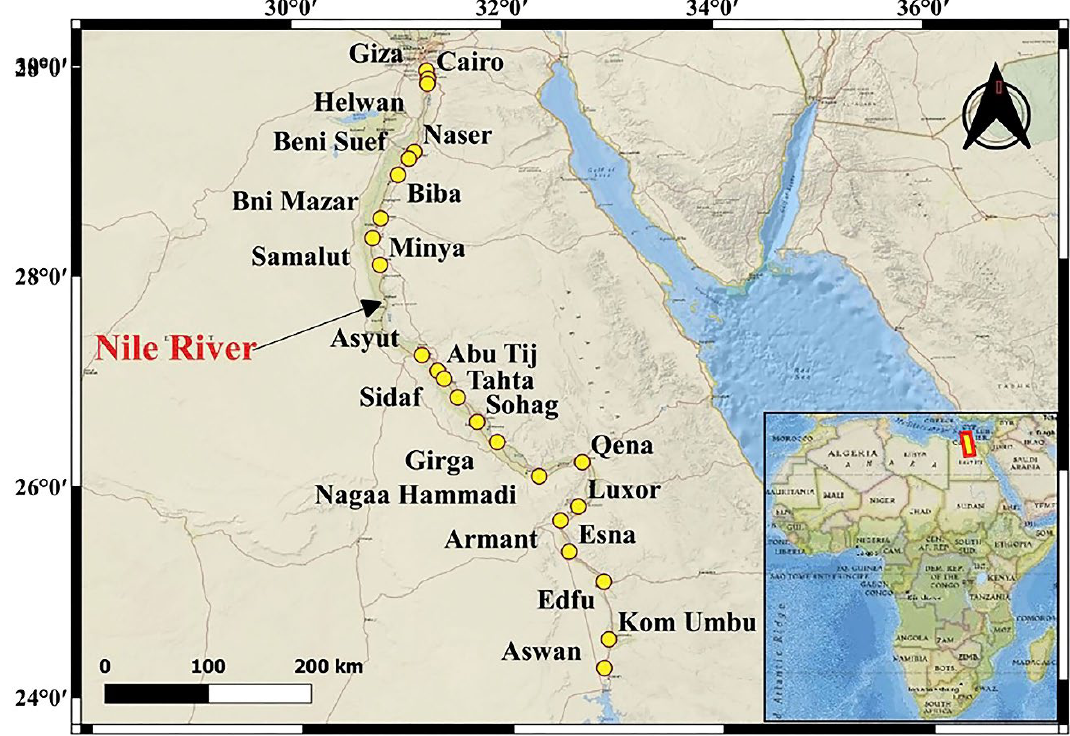
Figure 1. The location map of studied samples along Nile River, Egypt.